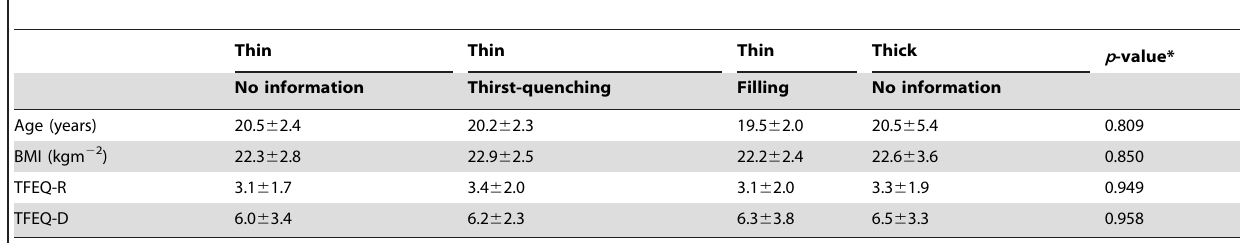
Table 1. Mean ( 6 SD) Age, BMI, TFEQ restraint and TFEQ disinhibition scores for the participants in the different beverage context groups.